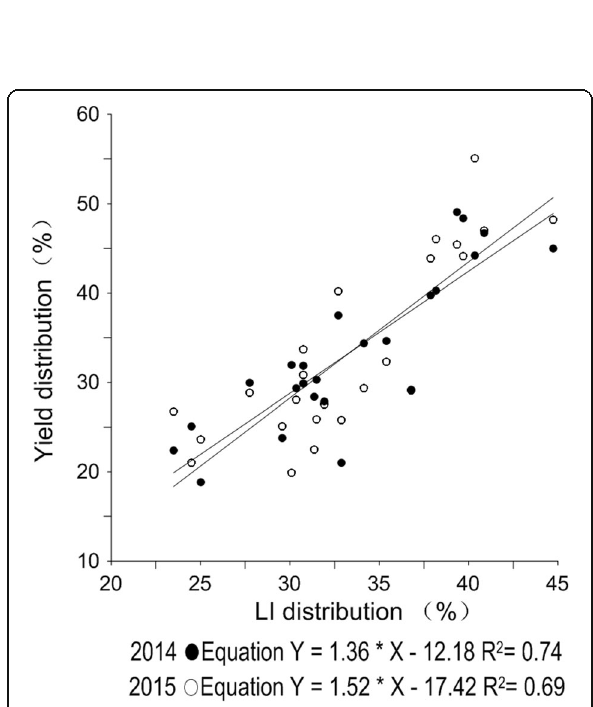
Fig. 8 Relationships between LI distribution and boll spatial distribution in 2014 and